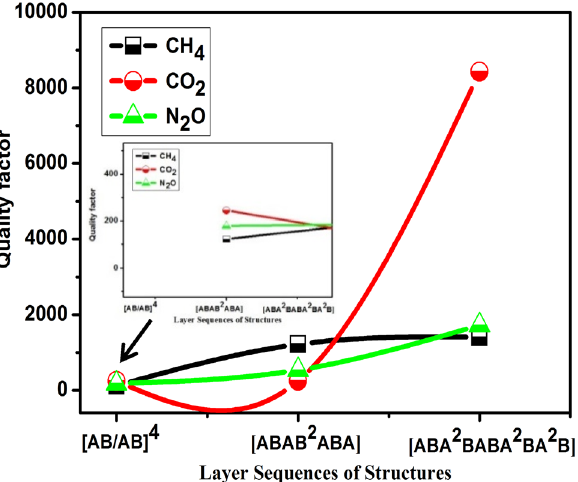
Figure 4. Shows the Quality factor of the periodic and F(5), FC(7, 1) quasi-periodic PhC gas sensor structures towards N 2 O, CH 4 , and CO 2